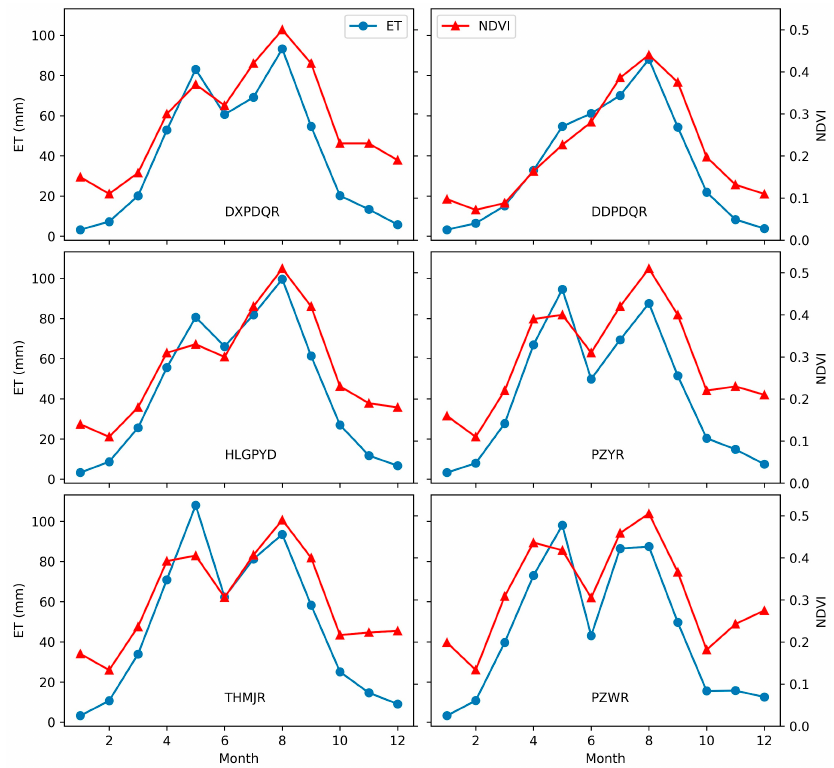
Figure 9. The variation of average ET and NDVI in DDPDQR, DXPDQR, PZYR, HLGPYD, THMJR, PZWR.